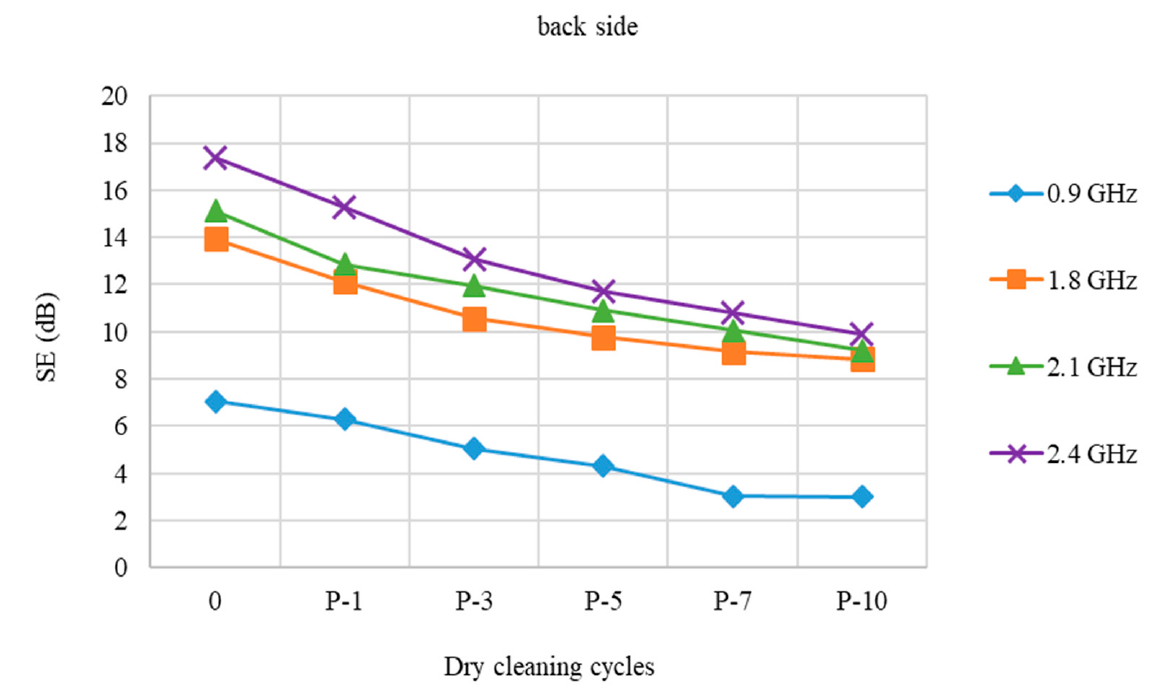
Figure 3. Shield effectiveness (SE) of PES/CO/SS fabric (back side) before and after 1st, 3rd, 5th, 7th, and 10th dry cleaning cycle (P) at frequencies 0.9 GHz, 1.8 GHz, 2.1 GHz, and 2.4 GHz.